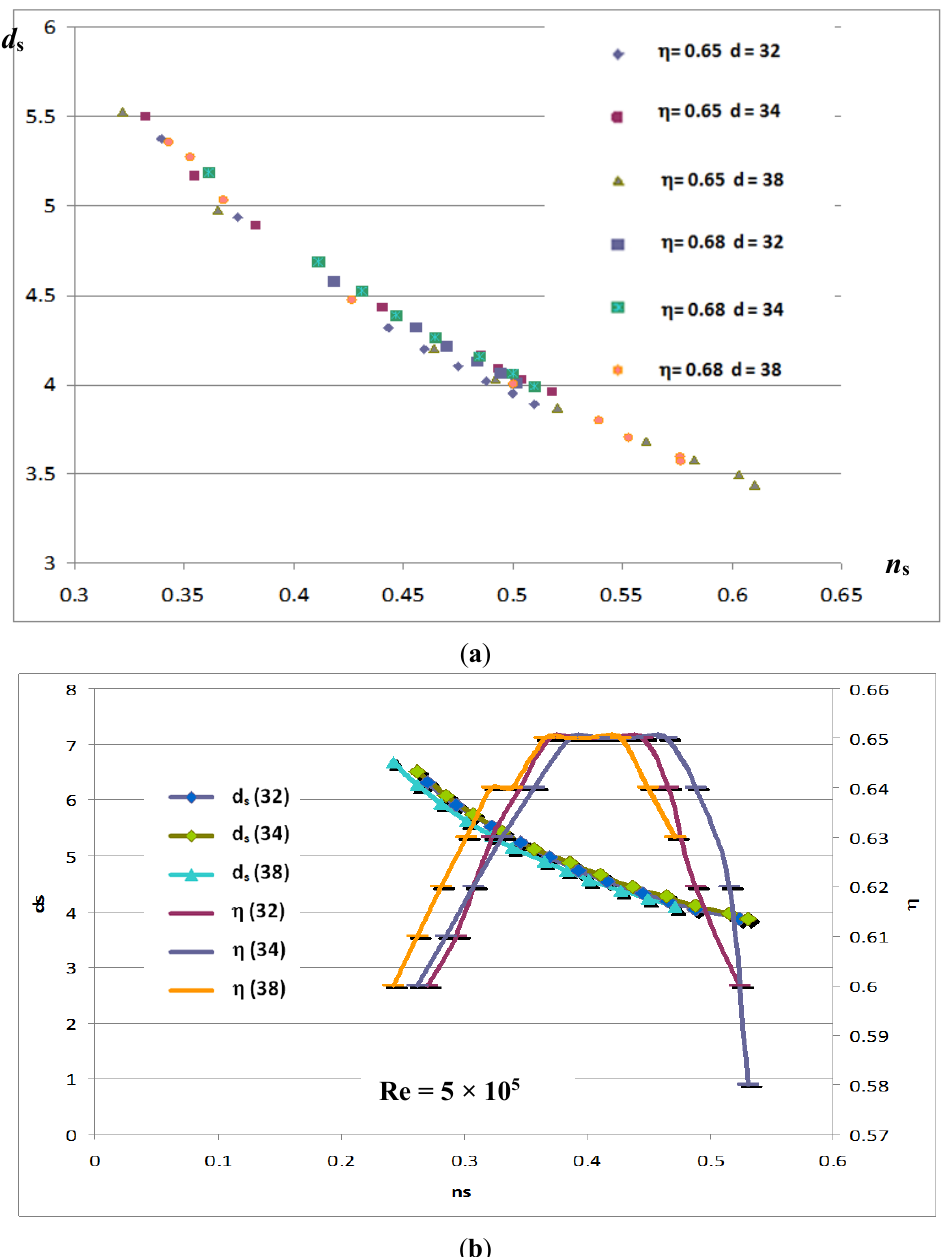
Figure 5. ( a ) Iso-efficiency points (Cordier line) for different compressor impeller diameter; and ( b ) d s and efficiency curves for a fixed Re and different compressor impeller